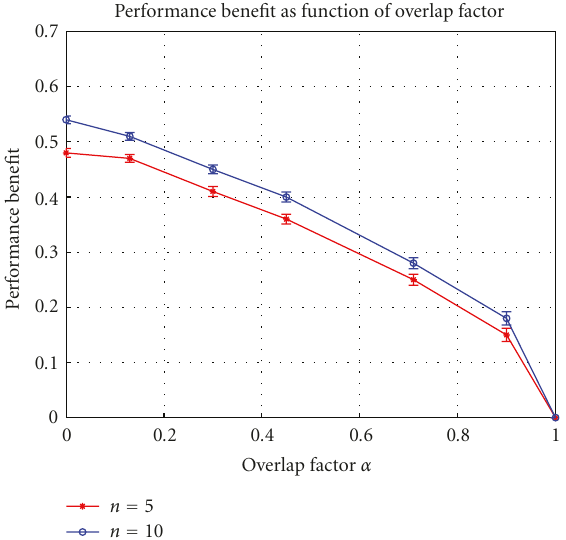
Figure 11: Performance gain through simulation for n = 5,10 and overlap factor